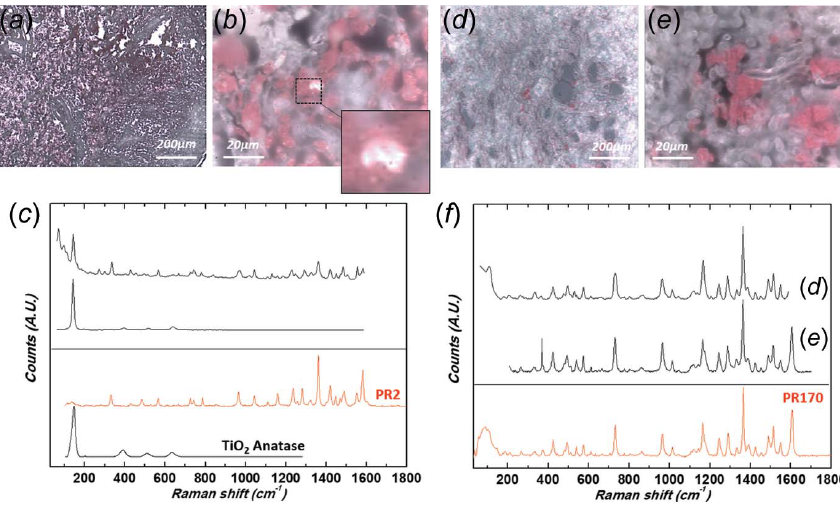
Figure 9 Raman spectroscopy: identification of azo pigments. ( a , b ) Optical micrographs of patient 6’s biopsy at two different magnifications [( a ) 10 (cid:4) and ( b ) 100 (cid:4) ] revealing the presence of micrometre-size clusters, mixture of PR2 and TiO 2 (inset: magnification of a white anatase pigment cluster). ( c ) Corresponding Raman spectra (without correction of the luminescence background). Reference spectra from the Soprano spectral library are also given as comparison (PR2, C.I. 12310, Monoazopigment, Naphthol AS) and anatase (TiO 2 ) downloaded from the RRUFF spectral library (ID R110109, 780 nm). ( d , e ) Optical micrographs of patients 2 ( d ) and 1 ( e ) revealing the presence of micrometre-size red pigments PR170. ( f ) Corresponding Raman spectra (excitation wavelength (cid:4) exc = 785 nm, objective 100 (cid:4) , numerical aperture = 0.9). Both spectra are baseline corrected. Reference spectra from the Soprano spectral library are also given as comparison (PR170 C.I. 12475, Monoazopigment, Naphthol AS).